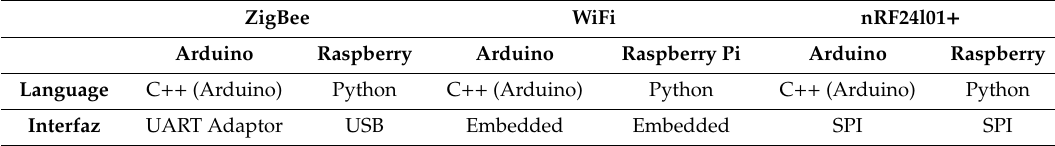
Table 2. Comparison of the programming languages and connection